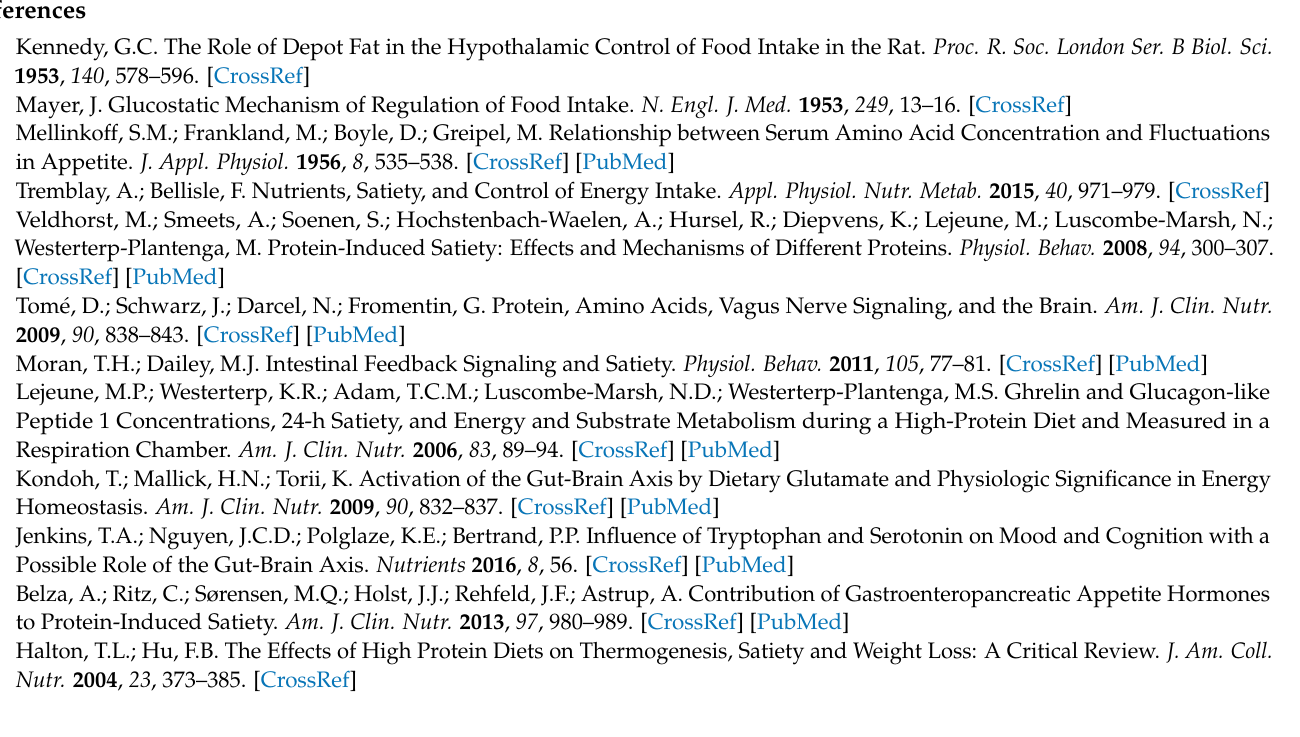
review; Figure S1: Funnel plot with one-time representation of all studies included in the primary meta-analysis; Figure S2: Meta-analysis of mean difference in body weight changes with 95% CI (kg) between exposures to various interventions with specific protein sources compared to matching